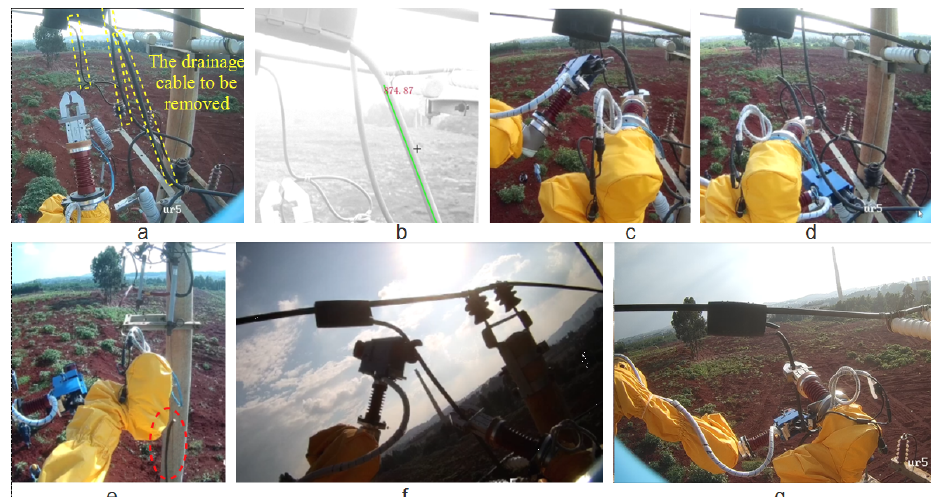
Figure 25. Field work: broken drainage operation on overhead lines. (( a ) Operating environment, ( b ) identify and locate cables, ( c ) cut the upper end of the near side drainage cable, ( d ) cut the lower end of the near side drainage cable. ( e ) discard drainage cable, ( f ) broken drainage operation for mid-phase drainage cable, and ( g ) broken drainage operation for far side drainage